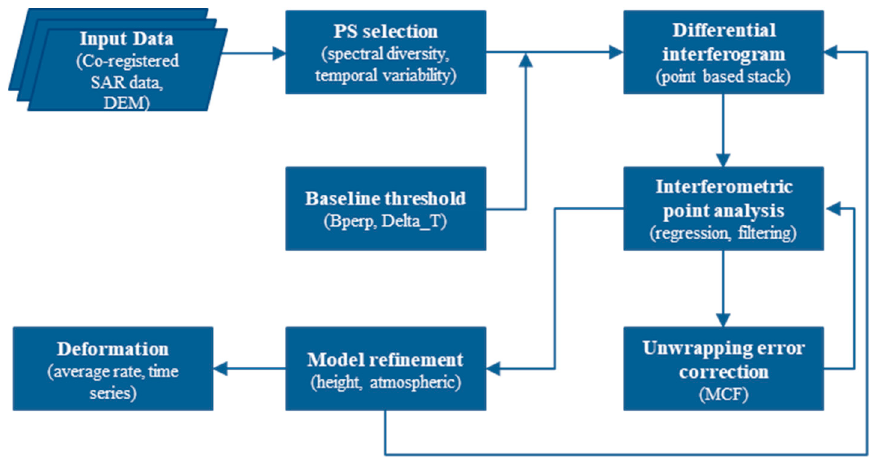
Figure 2. Processing workflow for interferometric point target analysis (IPTA).